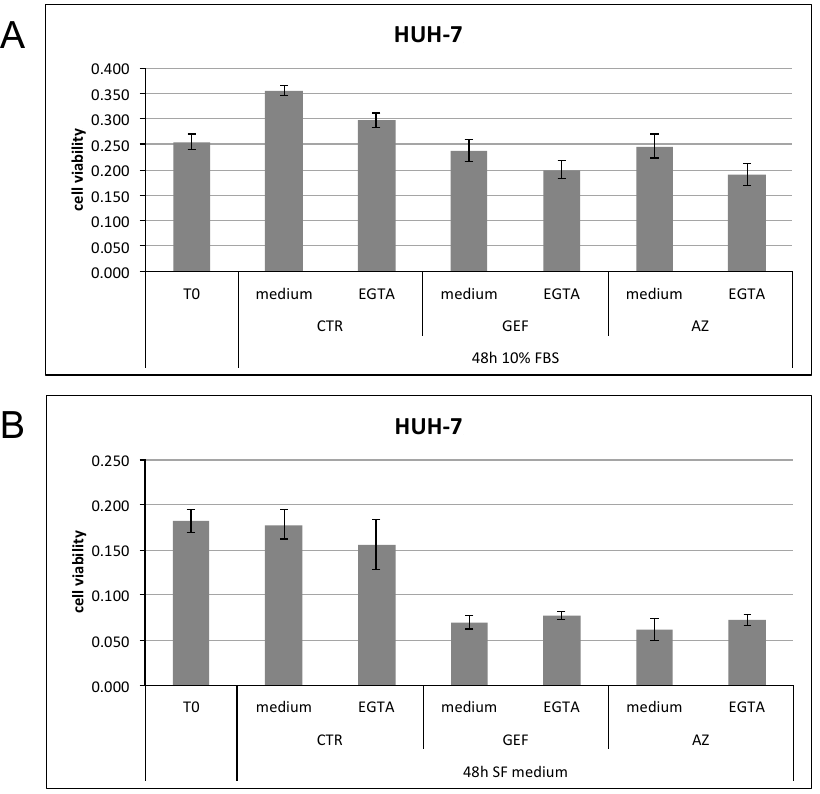
Figure 8. HUH-7 not starved (10% FBS ( A )) or starved (SF medium ( B )) cells were left untreated (medium as CTR) or treated with 2 mM EGTA for 48 h in the presence or absence of GEF or AZ. However, both calcium chelators, EDTA and EGTA, do not only act on calcium ions outside the